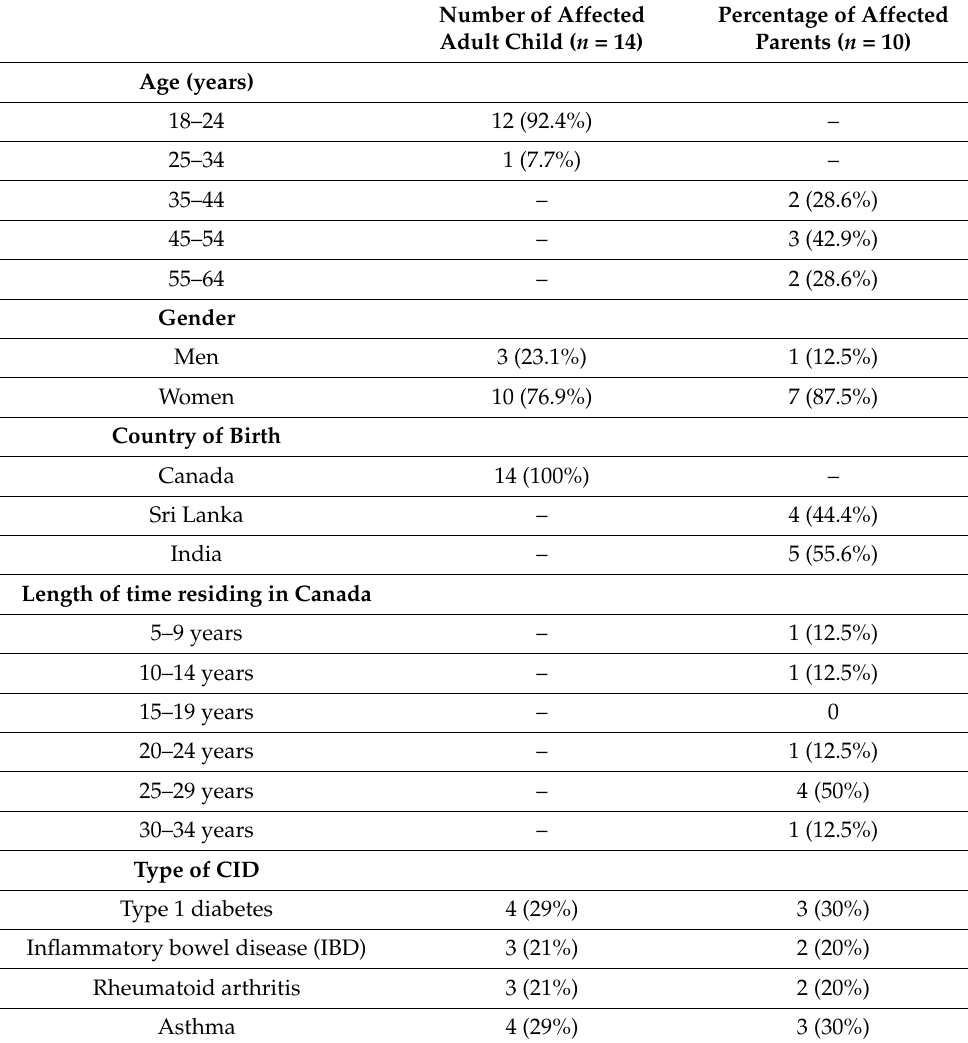
Table 1. Participant